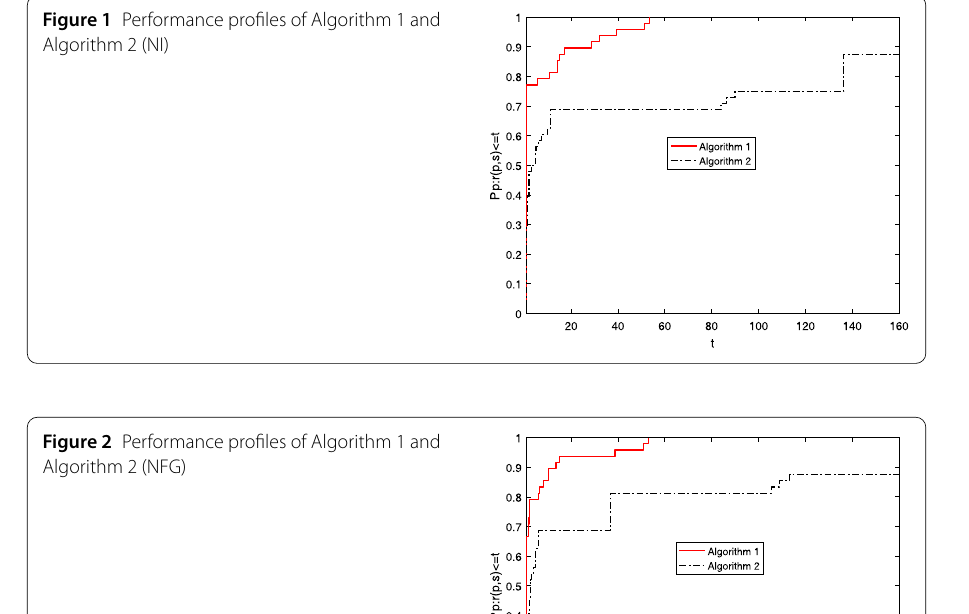
Figure 2 Performance profiles of Algorithm 1 and Algorithm 2 (NFG)